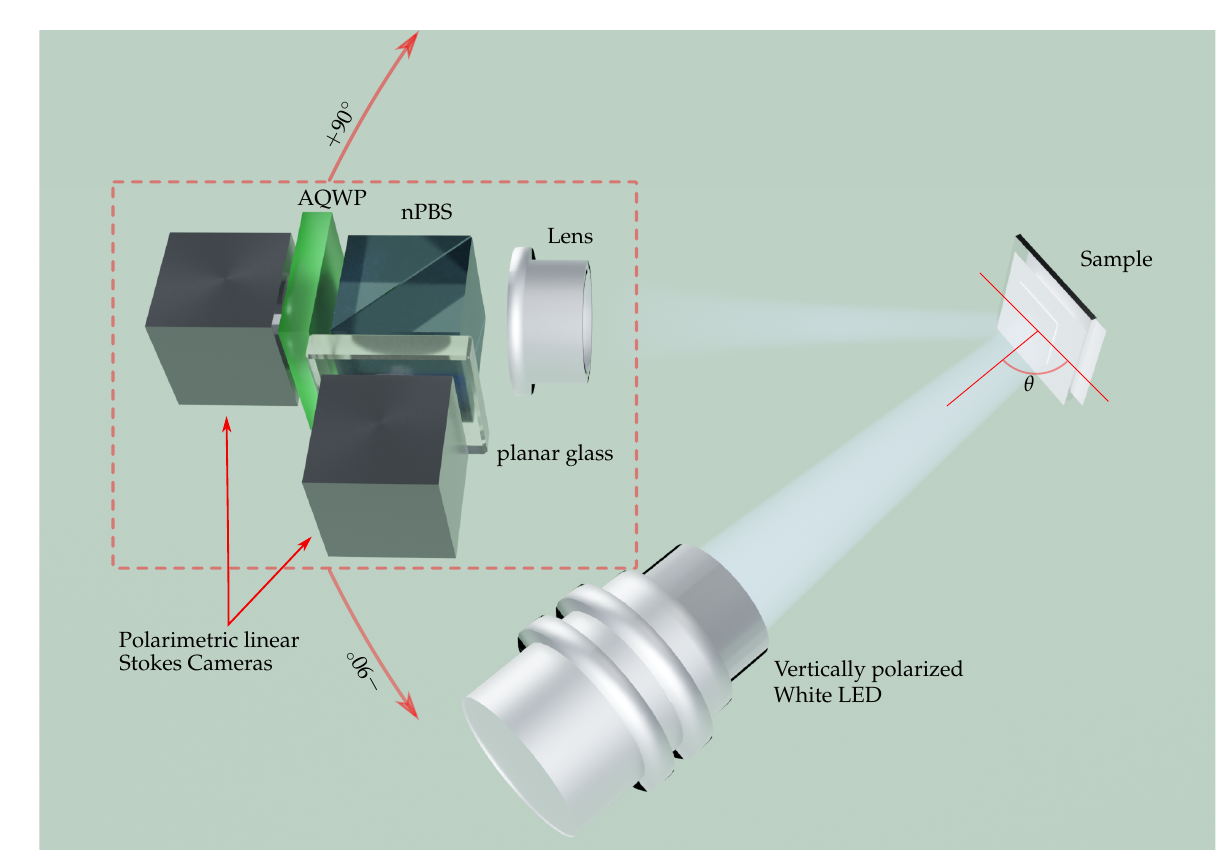
Figure 2. Active full-Stokes imaging